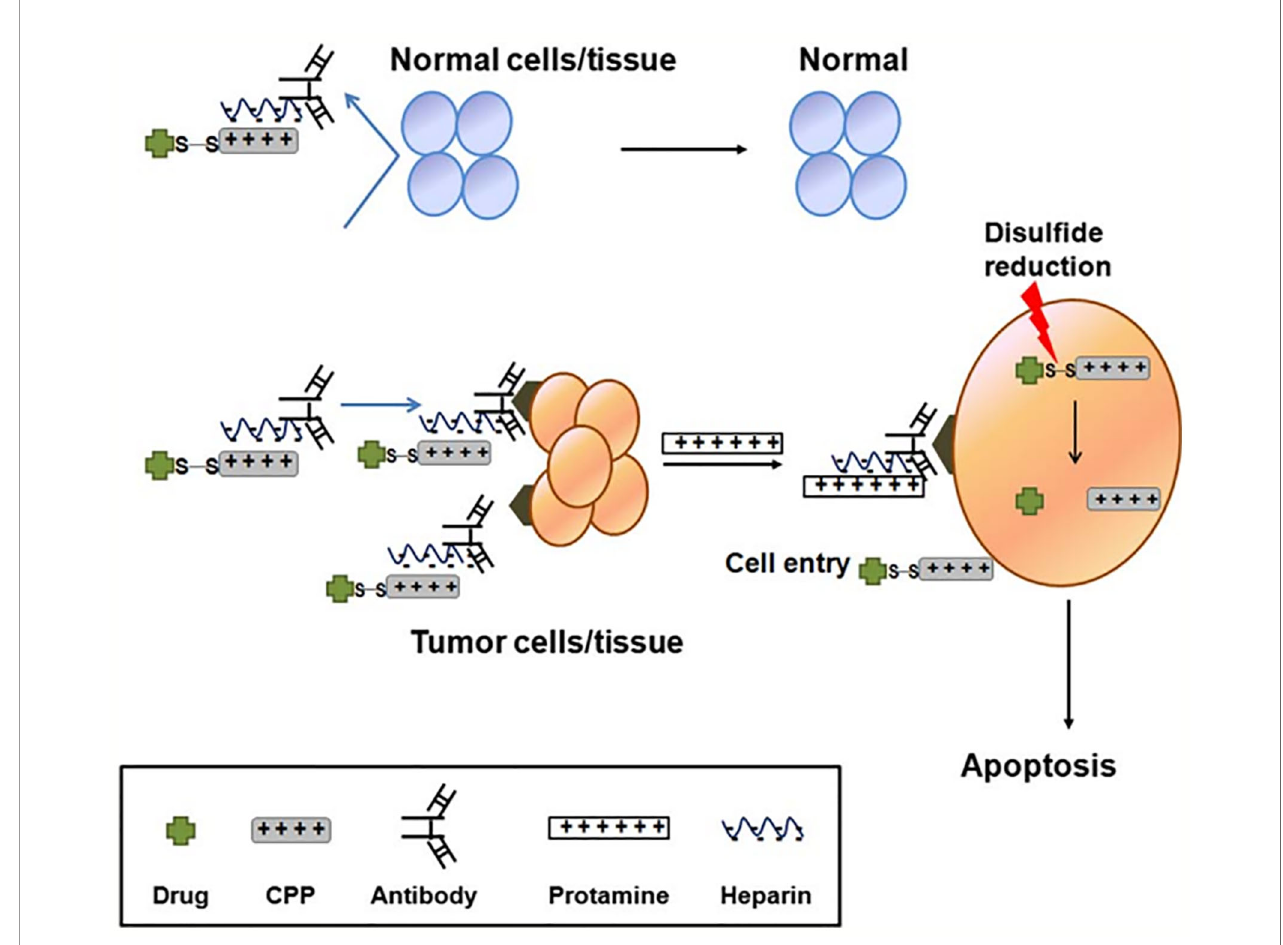
FIGURE 6 | Illustration of CPP-modi fi ed ATTEMPTS system (Shin et al., 2014) (with reproduction